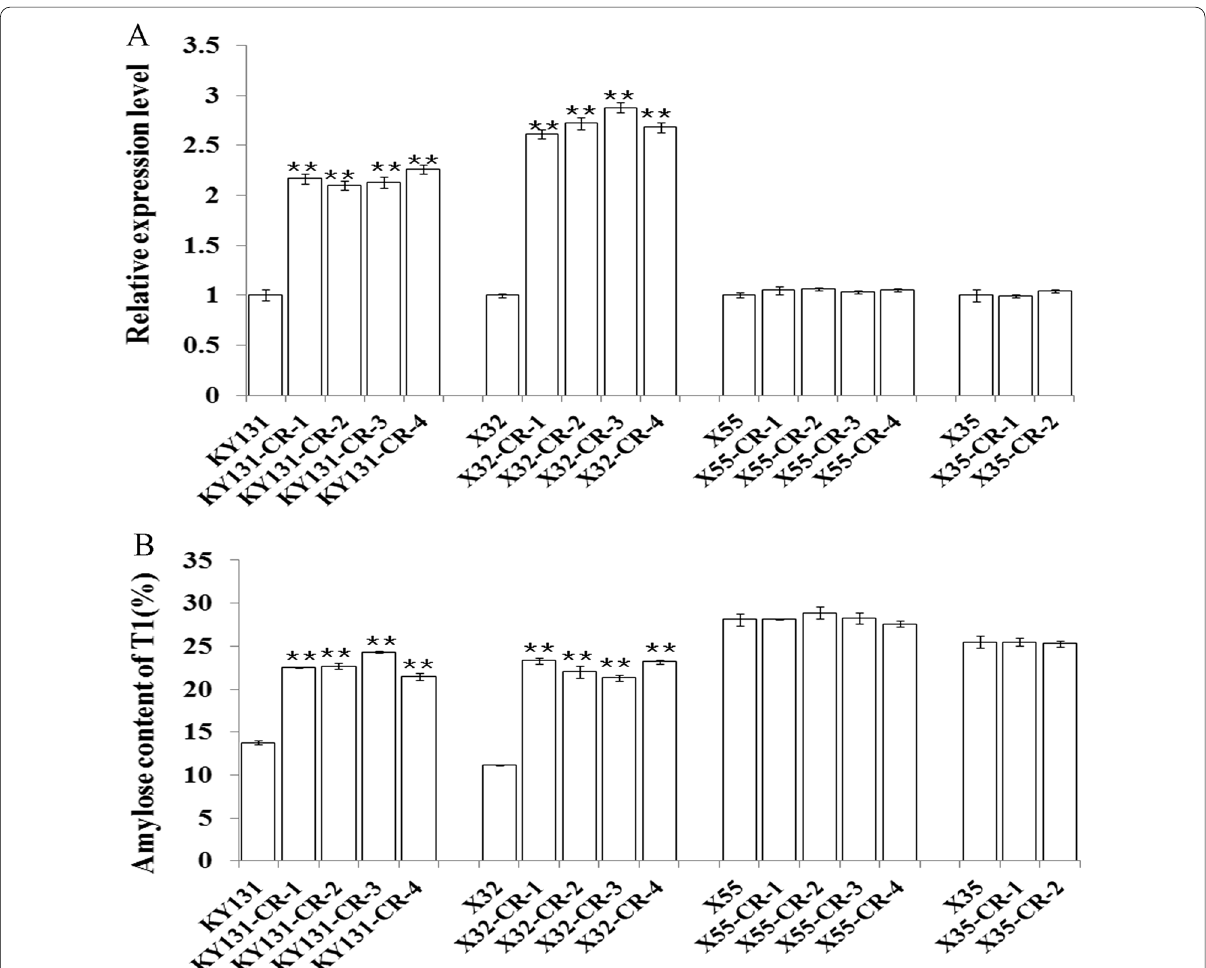
Fig. 2 Wx gene expression and amylose content of endosperm in wild-type and T1 mutants. A Relative expression level of the Wx gene in wild-type and mutant 1st-generation transgene-free homologous plants. The expression noted in WT plants was arbitrarily set to 1, and the relative expression value of mutants was obtained by comparing the mutant expression to WT expression. B Amylose content of endosperm in wild-type and 1st-generation plants of transgene-free homologous mutants. Data are presented as the mean P < 0.01 (t